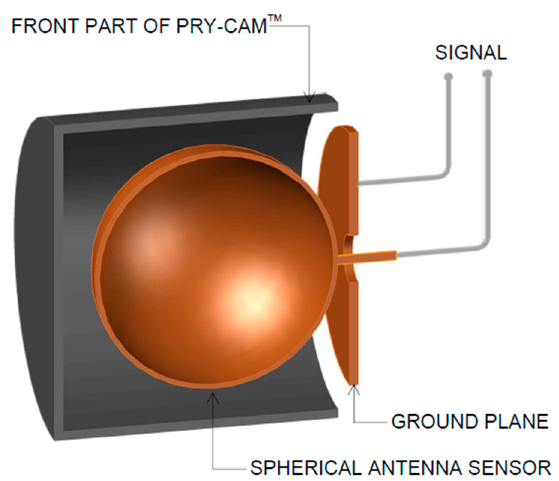
Figure 3. A sectional view of the front side of the Pry-Cam TM . (The partial discharge (PD) sensor is subject to patent, and this image is taken from the images contained in Reference [8] as an interpretation of the authors.).